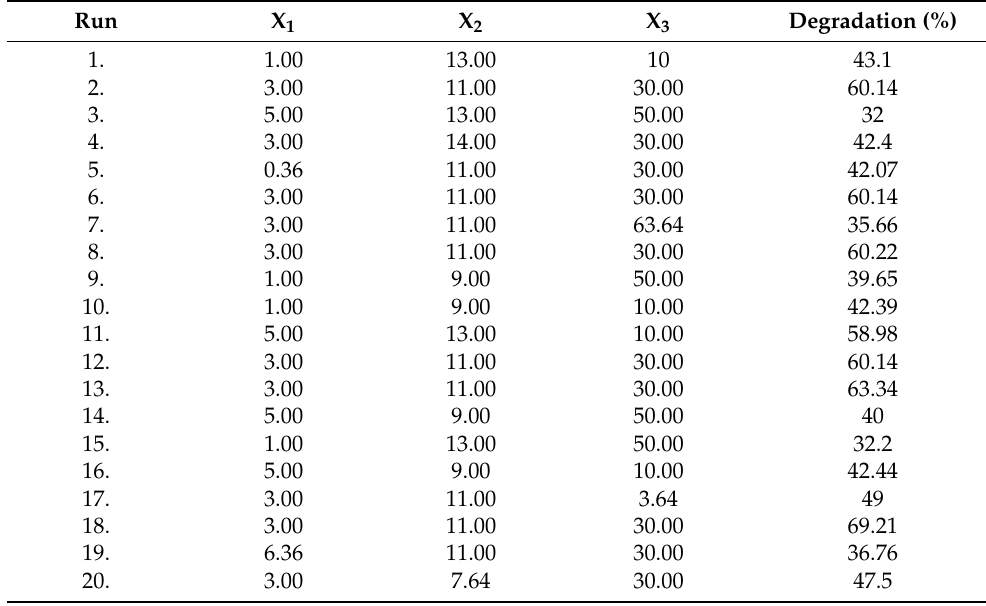
Table 3. Central composite design with variable values and percent degradation of